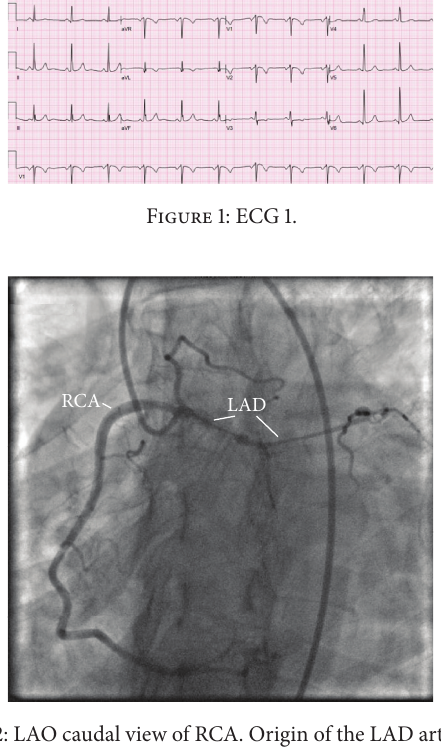
Figure 2: LAO caudal view of RCA. Origin of the LAD artery from the ostium of the RCA can be seen, along with severe stenosis of the proximal portion of the LAD artery.